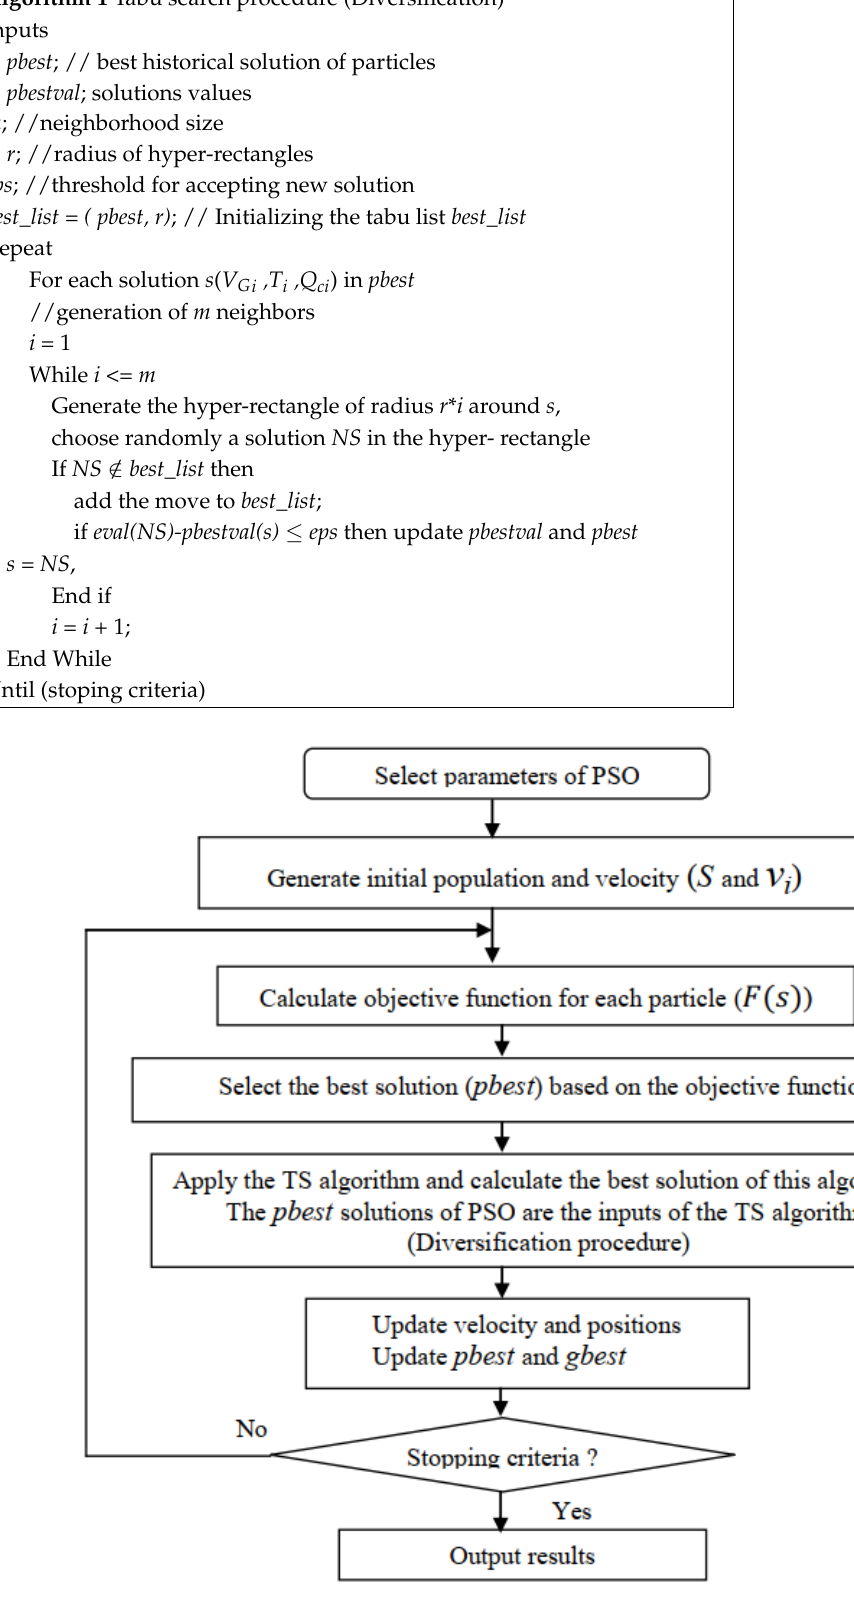
Figure 2. General flowchart of PSO-TS method .